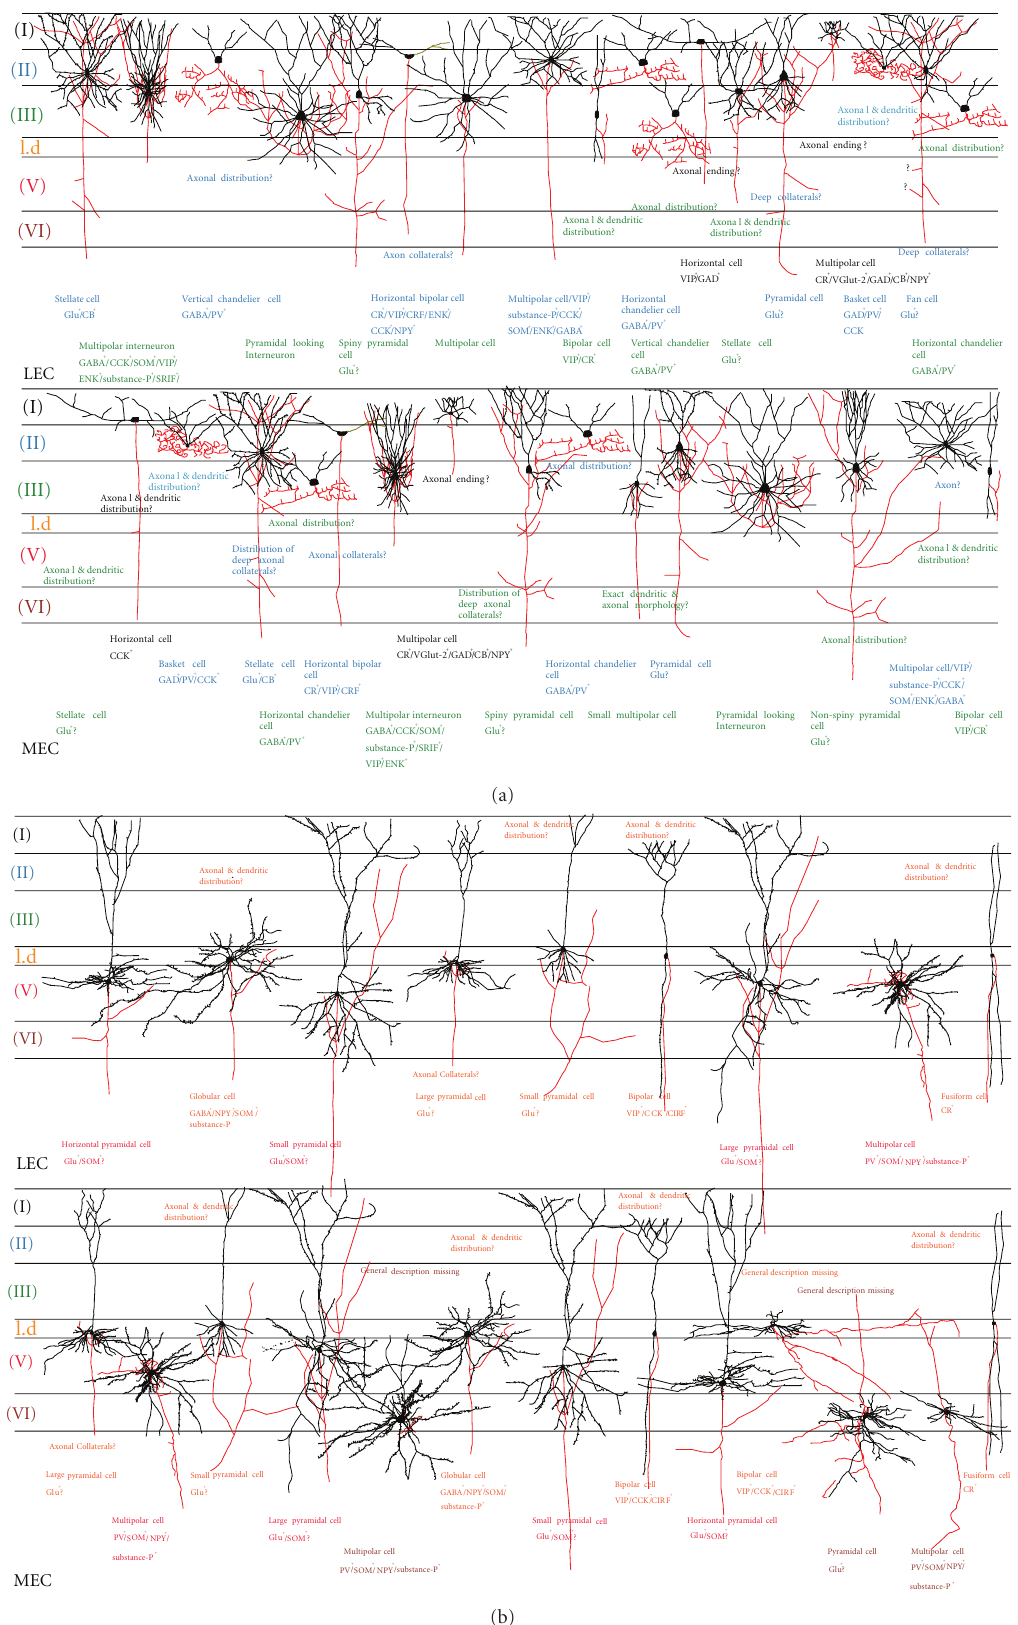
Figure 2: Summary diagram of the morphology of main cell types in LEC and MEC. (a) Cells in superficial layers I-III. (b) Cells in deep layers IV-VI. See text for more